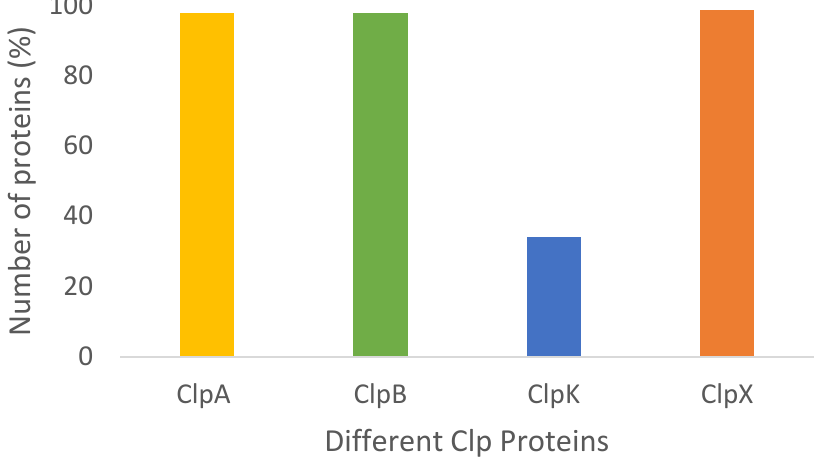
Figure 2. Clp proteins identified in the investigated Klebsiella strains. The total number of Clp proteins obtained from the National Center for Biotechnology Information (NCBI) Genome database, was tallied.